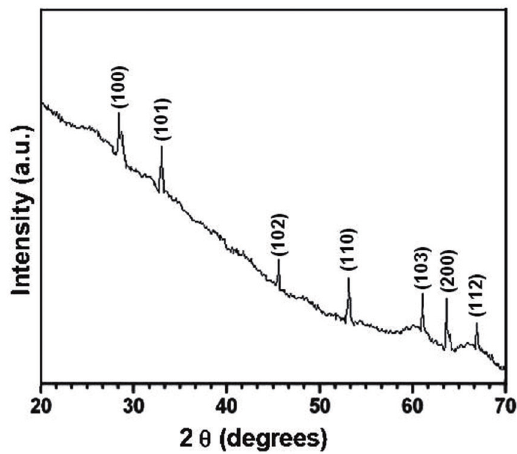
Figure 4: Plot of (αhν) 2 versus